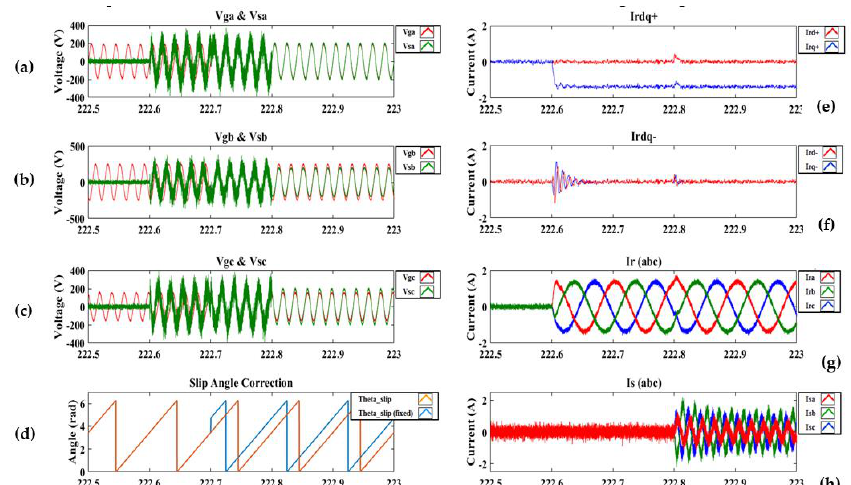
Figure 8. Experimental results for DFIG soft synchronization to the grid using standard procedure. ( a ) Phase-A grid and stator voltages ( b ) Phase-B grid and stator voltages ( c ) Phase-C grid and stator voltages ( d ) Phase angles di ff erence ( e ) Positive sequence rotor current components ( f ) Negative sequence rotor currents components ( g ) Three phase-Rotor currents ( h ) Three phase-Stator currents